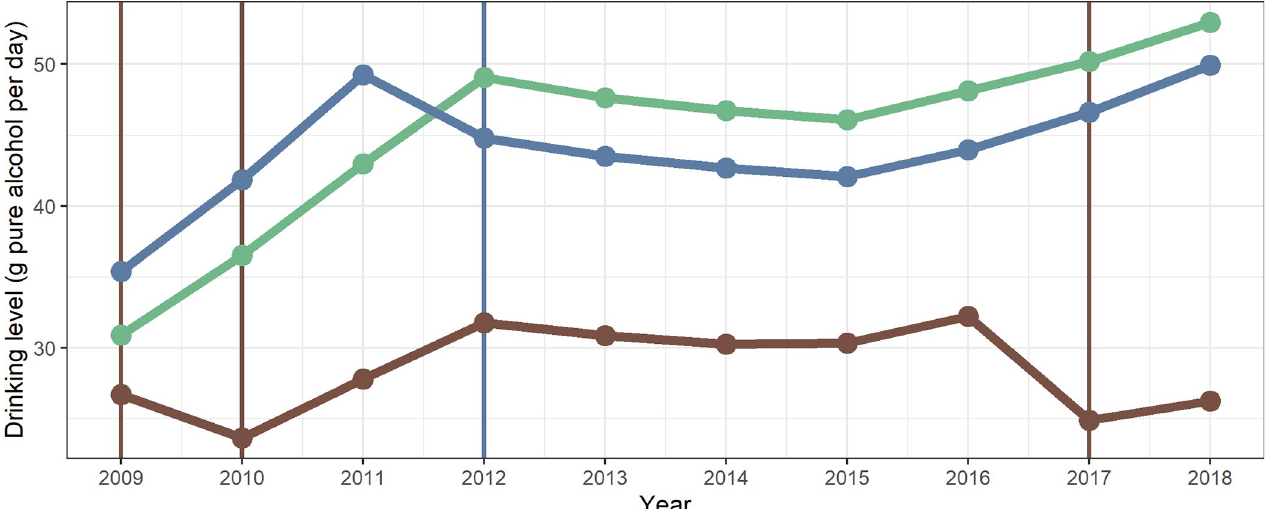
Fig 2. Trajectory of daily drinking levels for three individuals. Each colour represents one individual and the vertical lines indicate reception of an intervention in that year (see text for explanation).